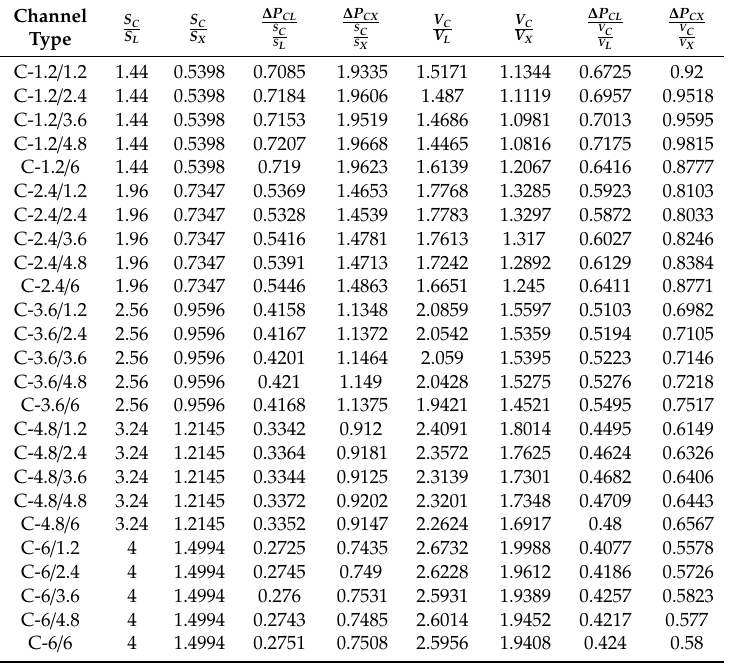
Table 5. Results of full factorial design for C ‐ r i /r o.